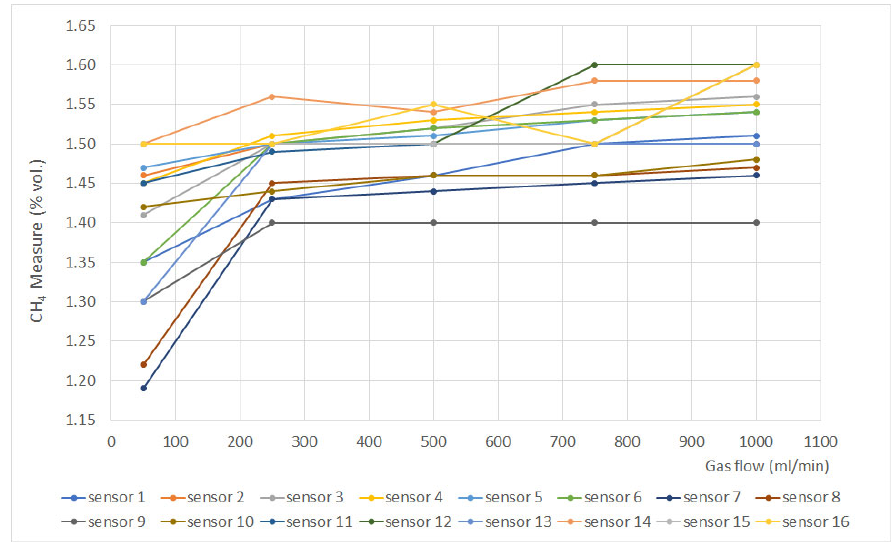
Figure 1. Flow rate results.